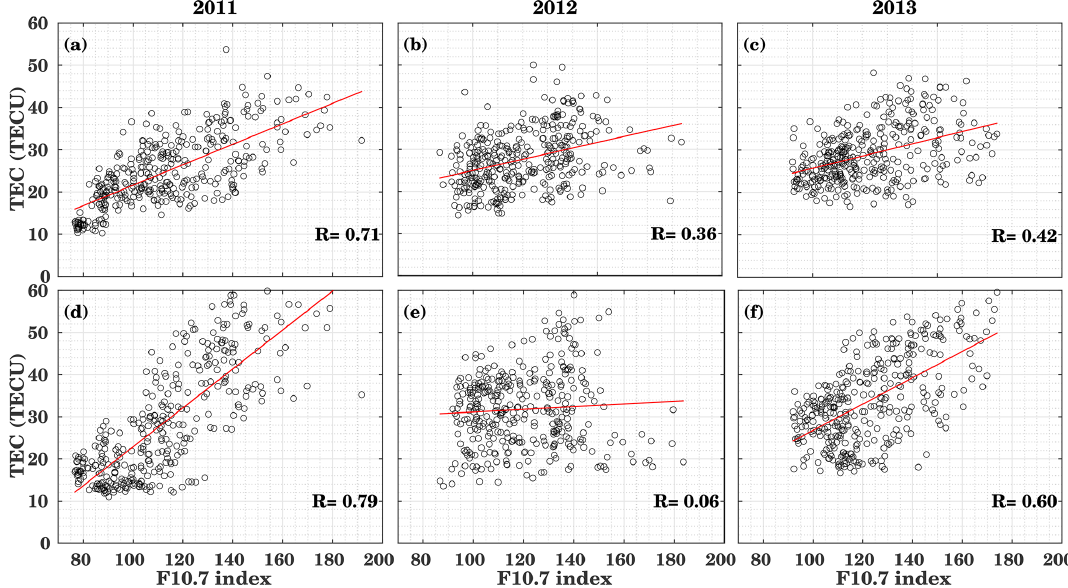
Figure 5. Relation between F10.7 index and midday-observed TEC (11:00–13:00LT) at 40 ◦ N, 15 ◦ E (a, b, c) and 40 ◦ S, 15 ◦ E (d, e, f) for 2011, 2012, and 2013. The red line is the linear